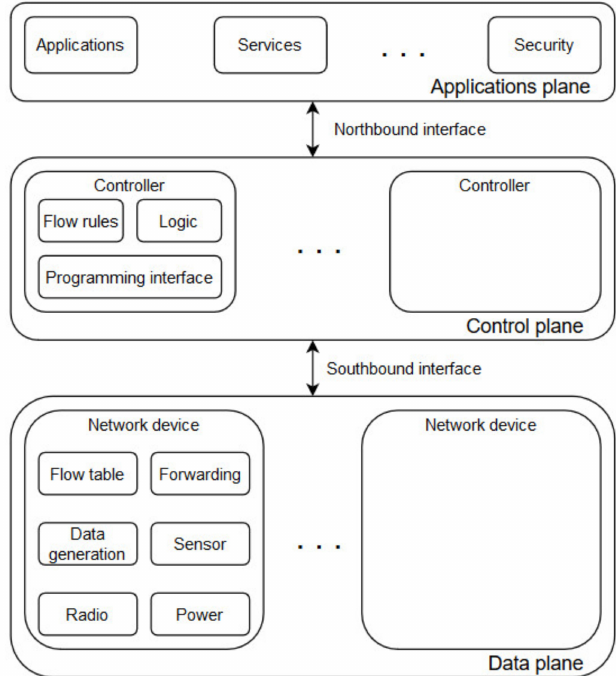
Figure 2. Traditional SDWSN